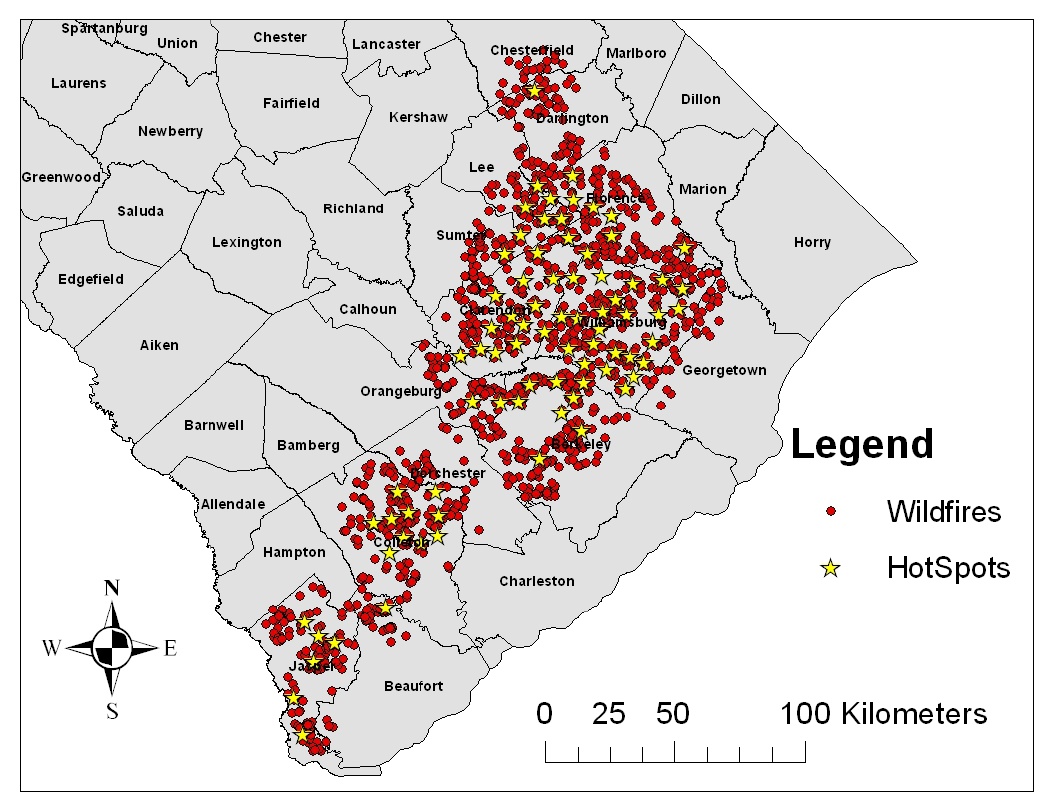
Figure 5. Wildfires within a 16 km radius of hot